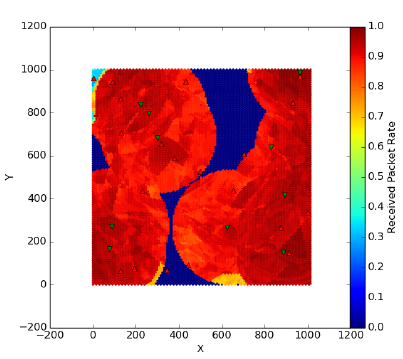
Figure 6. RPR with 10 noise nodes at h =60m Figure 7. RPR with 20 noise nodes at h =60m